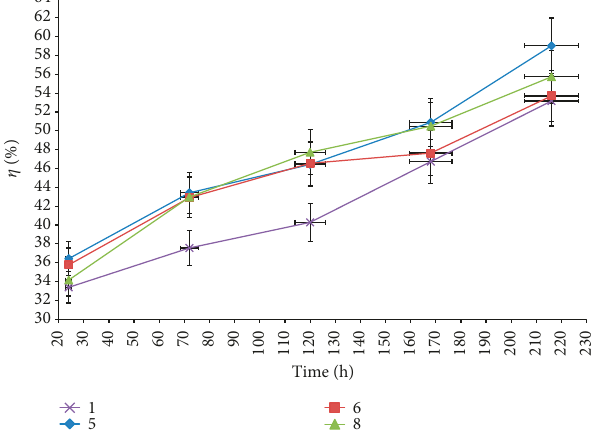
Figure 2: Relation between inhibition efficiency of aminopyridine derivatives in 6 M HCl and time at room temperature at 400ppm.